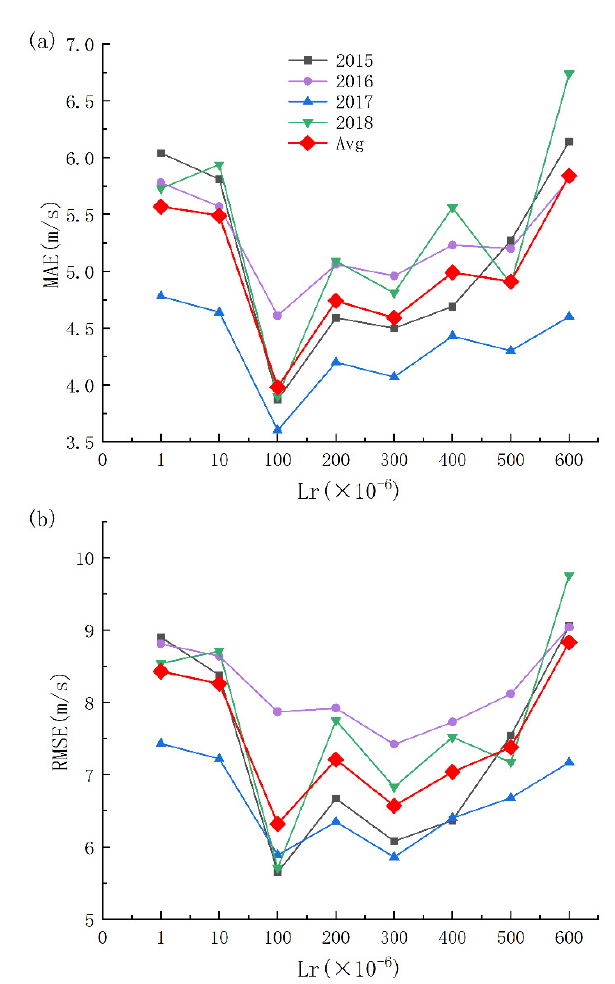
Figure 6. The forecasting results of 24 h ahead with various Lrs from 2015–2018 based on the TITP-Net model. ( a ) Evaluation of the MAE from 2015–2018 and the four-year average error. The point plots of each color represent the 24 h typhoon intensity forecast errors and the four-year average error of different Lrs in 2015–2018, respectively. The red point plot shows the four-year average error in various Lrs. ( b ) Evaluation of the RMSE from 2015–2018 and the four-year average